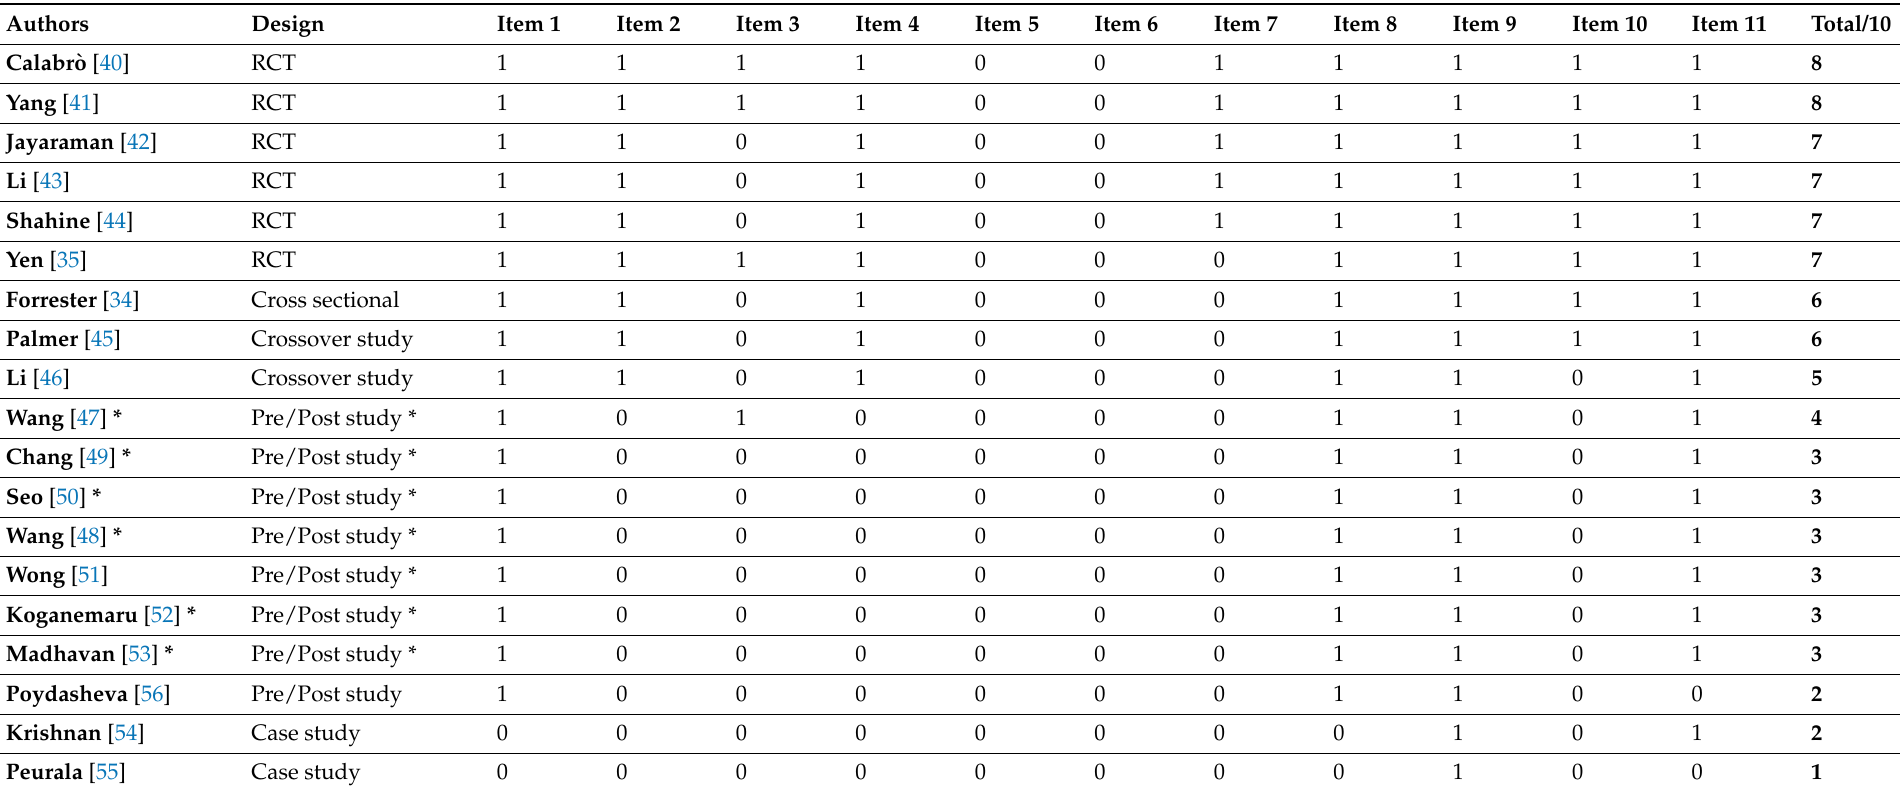
Table 1. Study design and quality assessment (PEDro score) of the included